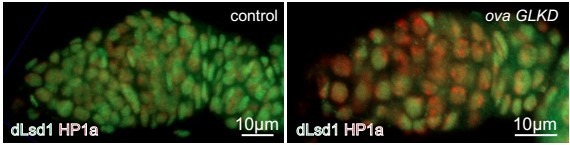
dLsd1 and HP1a expression and subcellular localization in control and ova GLKD germaria